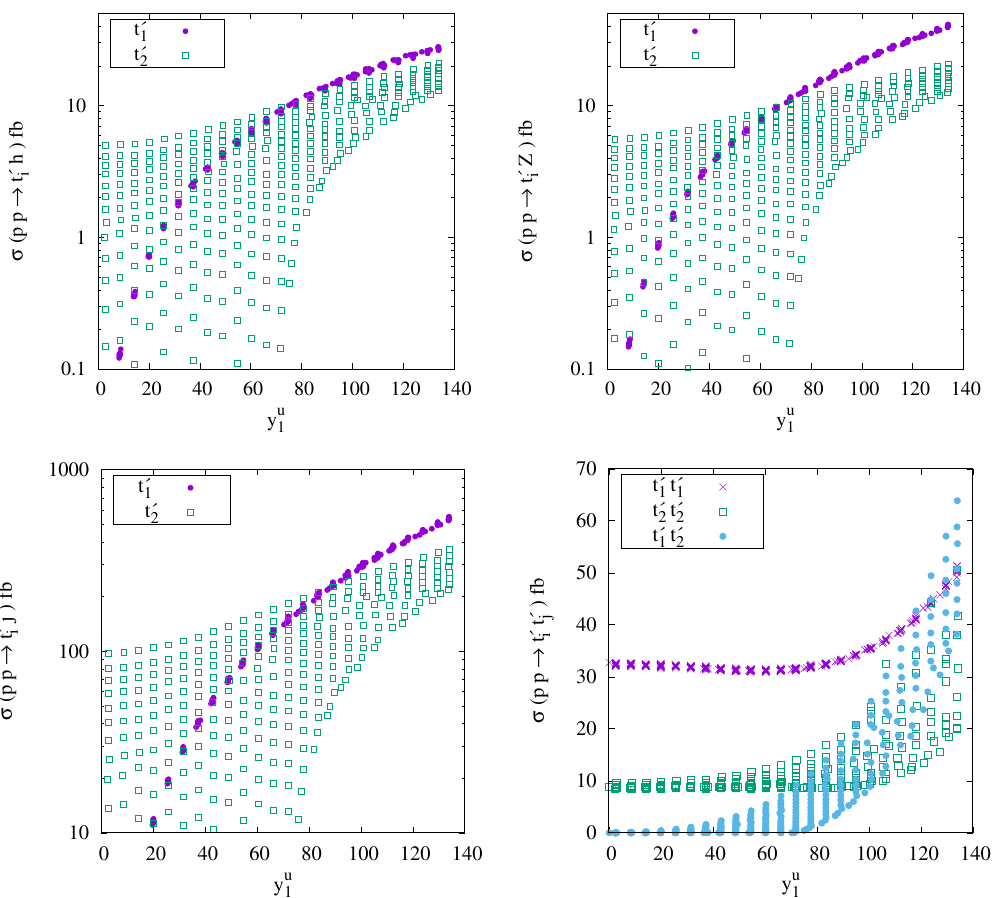
Figure 8 . Scatter plot of production cross-sections at LHC@13TeV, scanning over the Yukawa coupling of t 0 , for the production processes (from top left clockwise): t 0 2 with ( i; j = 1 ; 2) and with M 1 = 1000 GeV and M 2 = 1200 GeV. The cross-section include also the production of the anti-particle states t 0